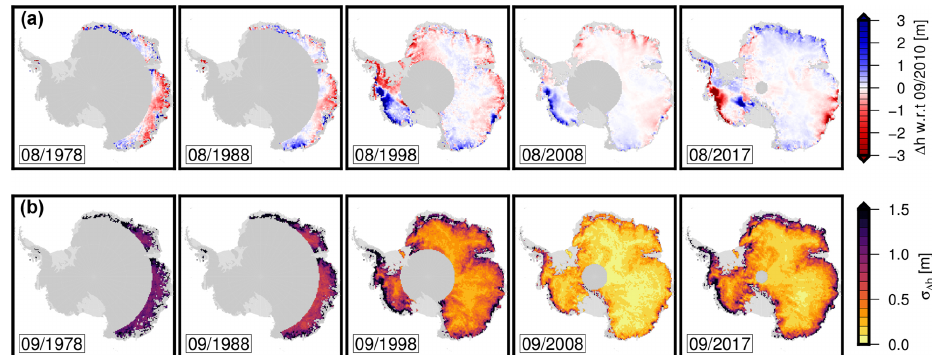
Figure 6. Five example snapshots of the resulting combined surface elevation time series (a) and their corresponding uncertainty (b) . The height differences refer to our reference epoch 09/2010.